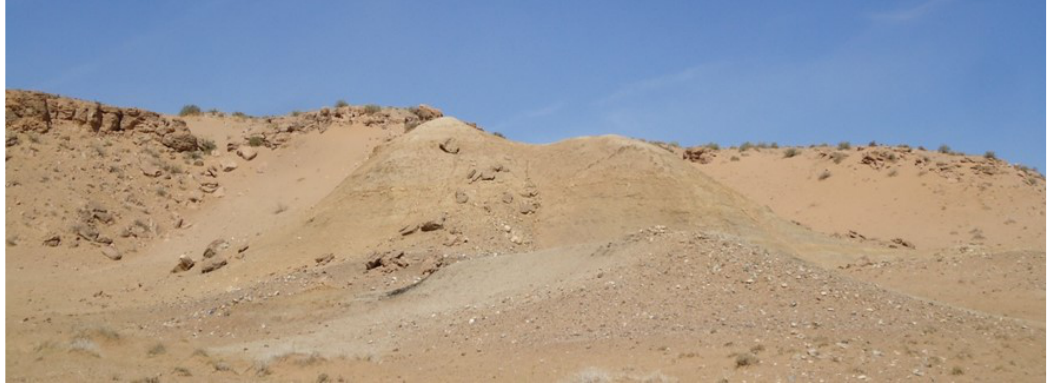
Fig. 6. Upper Sandstone-Clay package of the section